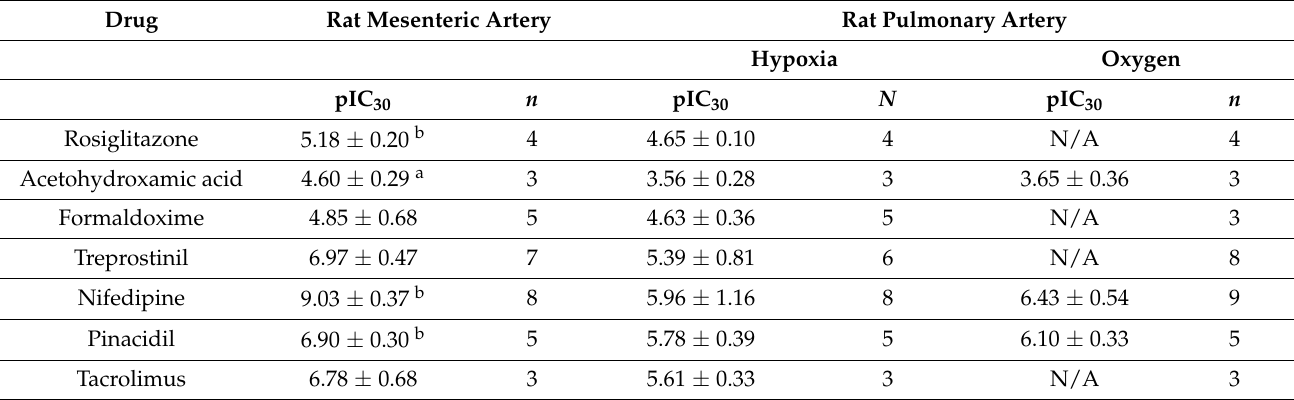
Table 3. pIC 30 values calculated from the concentration-response curves induced by different drugs in rat arteries. Drug